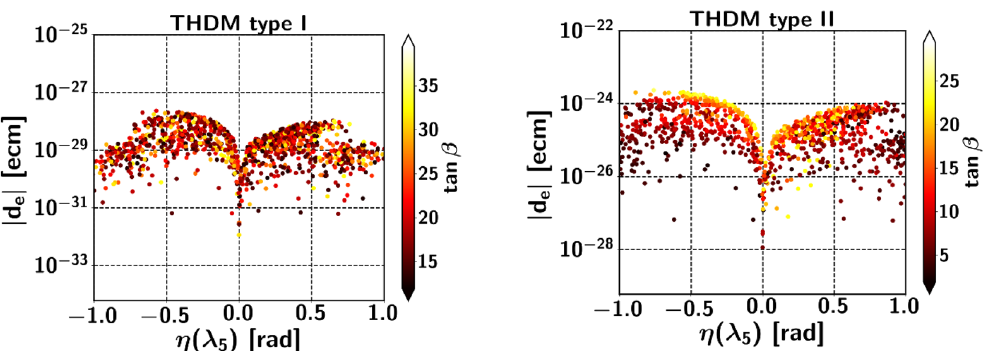
Figure 1 . Electron EDM versus η ( λ 5 ) as a function of tan β for type I and type II THDMs. Points in the plots satisfy all constraints including the Higgs data (at 2 σ